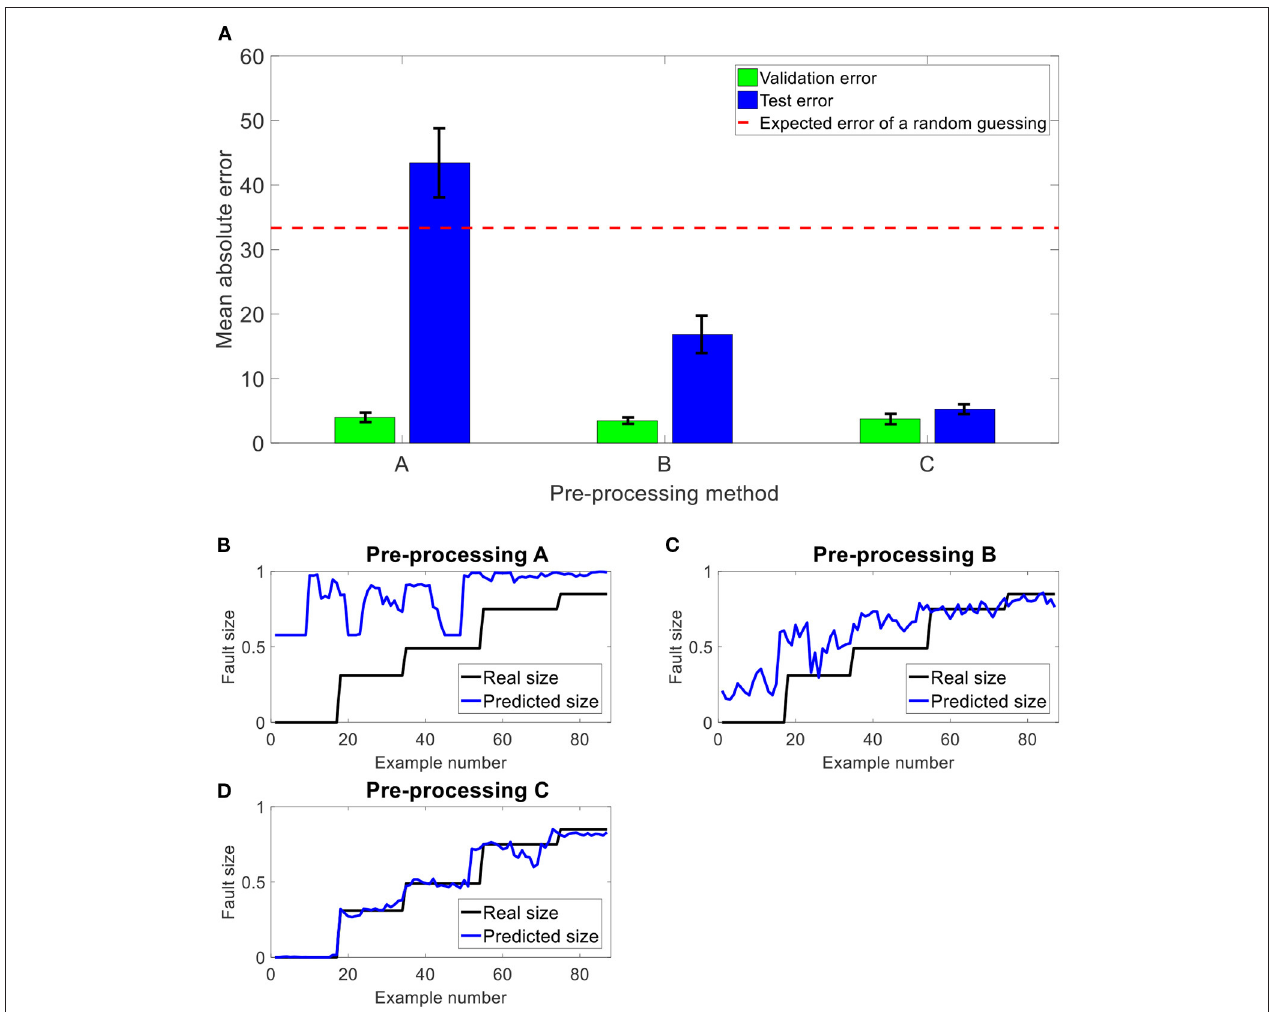
FIGURE 9 | Results of the CNN over three types of pre-processing methods. (A) The mean errors and their standard deviation (black) of the CNN over the validation and test sets, repeated 20 times. For each pre-processing method – A, B and C – an example of the predicted and real sizes of the test’s signals are presented in (B–D) ,